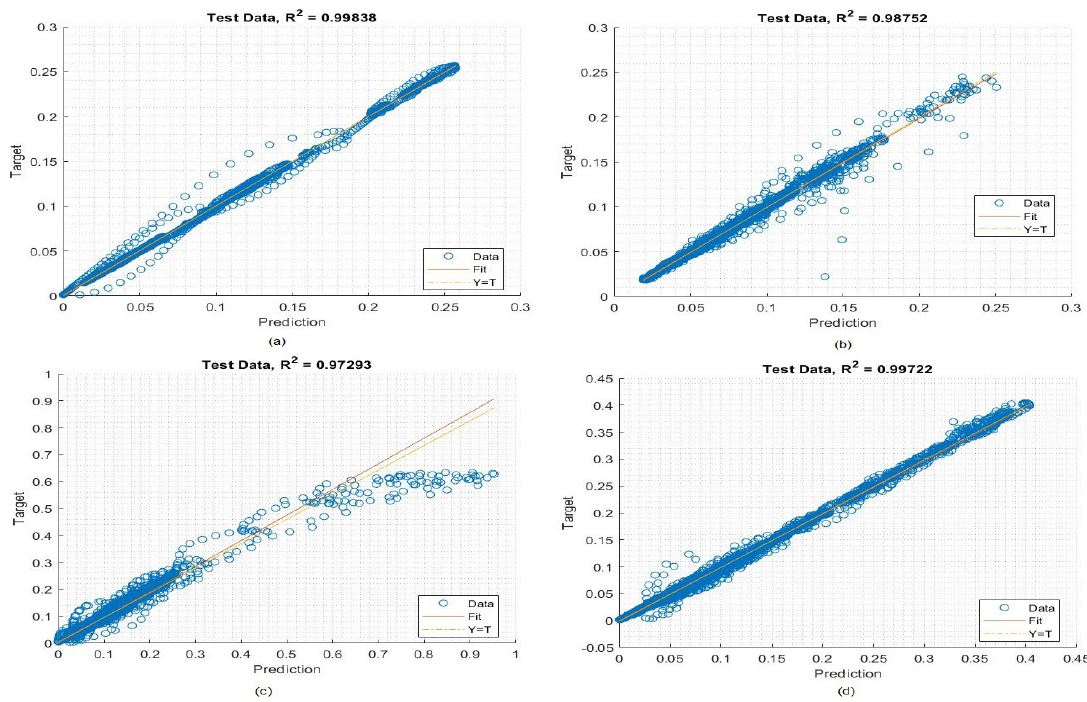
Figure 17. Regression plot of LSTM for predicting stock markets in Saudi Arabia in the testing phase, ( a ) communication ( b ) energy, ( c ) financial and ( d ) industrial sectors.